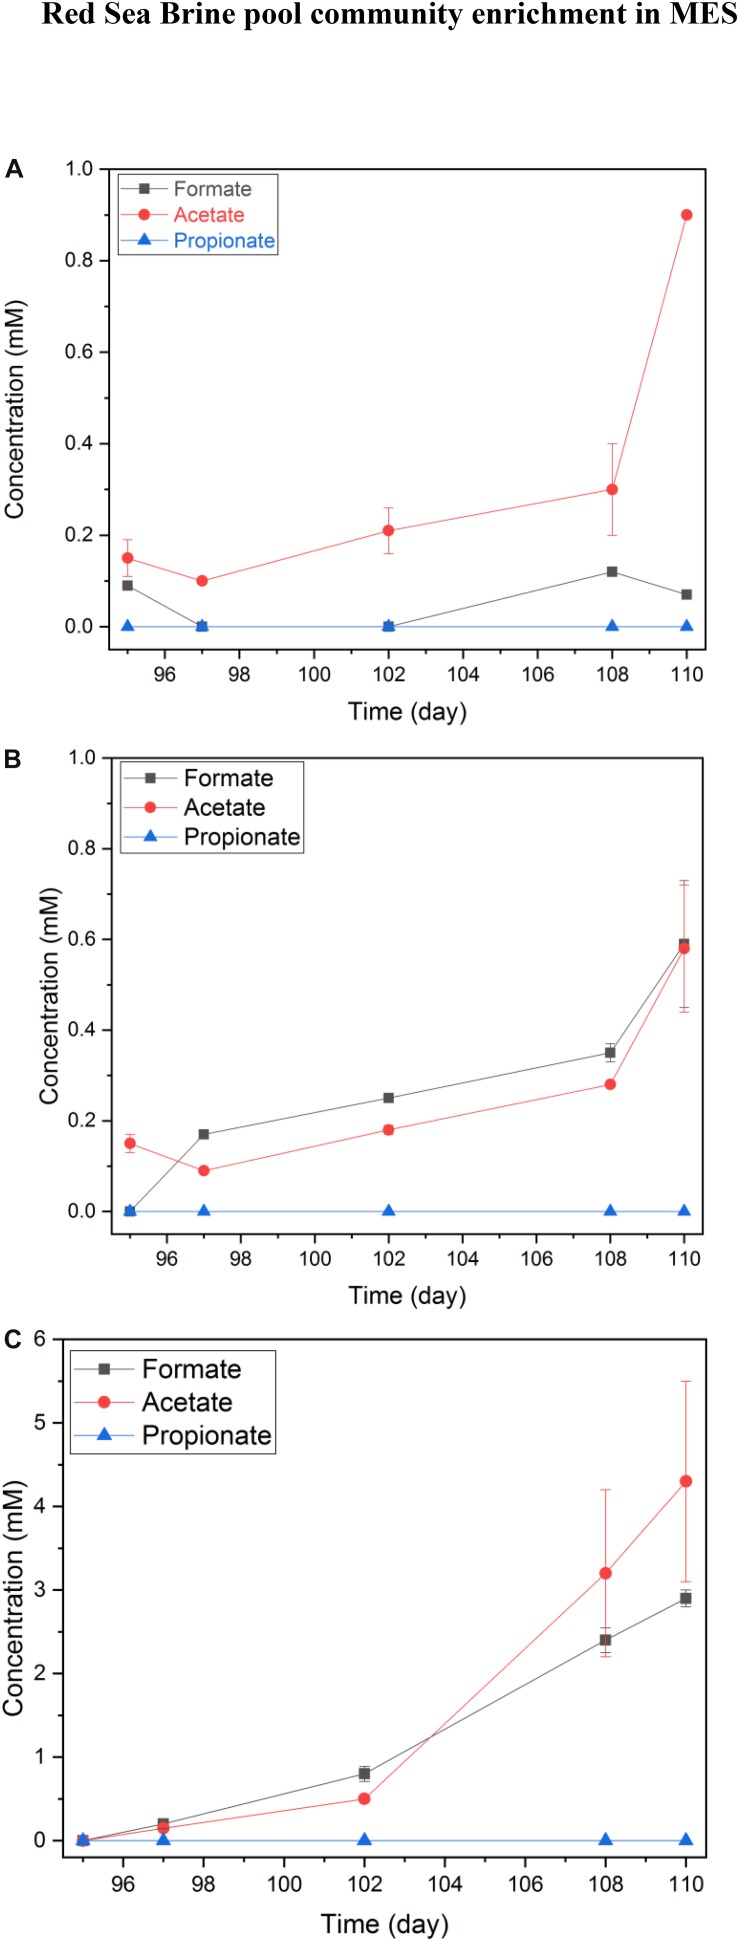
Average short-chained VFAs concentrations in MES reactors during phase II of operation. (A) average of duplicate MES reactors (MES 1 and 2) inoculated with enriched biocathode from phase I MES reactors (i.e., R1 and R2) and operated using synthetic saline media (10% salinity), (B) average of duplicate MES reactors (MES 3 and 4) inoculated with enriched culture from H2:CO2 serum vial (phase I) and operated with 10% using synthetic saline media (10% salinity), and (C) average of two batches for MES reactor (MES 5) inoculated with enriched culture from H2:CO2 serum vial (phase I) and operated using synthetic saline media (3.5% salinity). The data in (A,B) are based on one batch of operation, which is representative of several reproducible batches of operation.